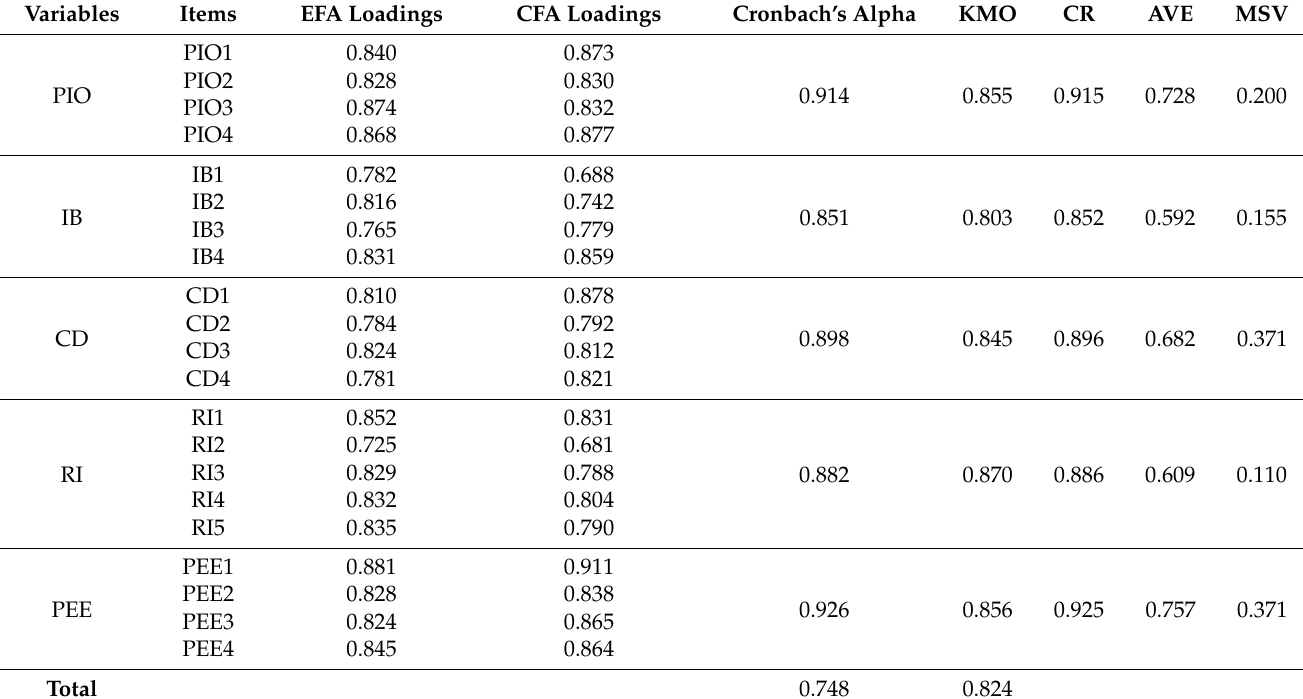
Table 2. Reliability and Validity Analysis Results.